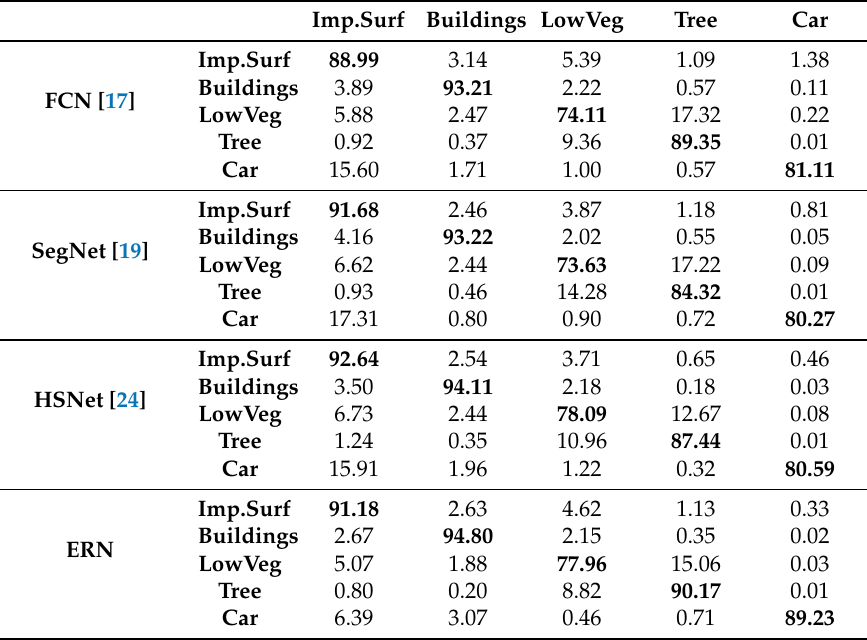
Table A2. Confusion matrix on the ISPRS Vaihingen Dataset. Imp.Surf: impervious surface; LowVeg: low